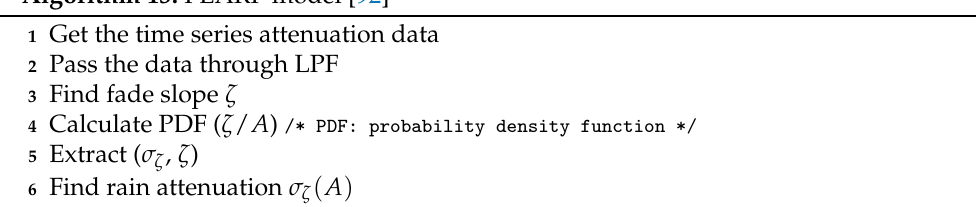
Algorithm 13: PEARP model